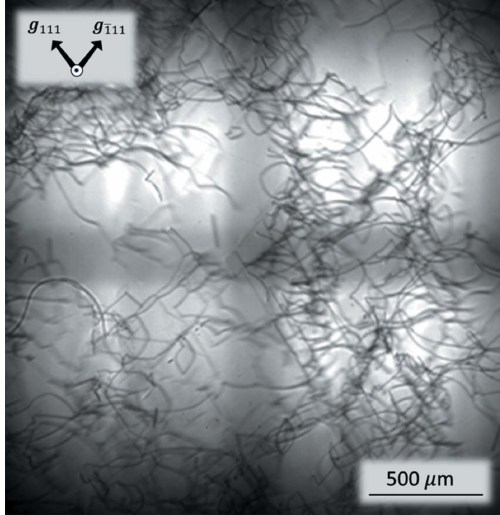
Figure 5 X-ray topograph of a germanium slab taken by simultaneous 111 and (cid:2) 1111 reflections without deformation correction. Four shots of images are pasted together to obtain a wide-area